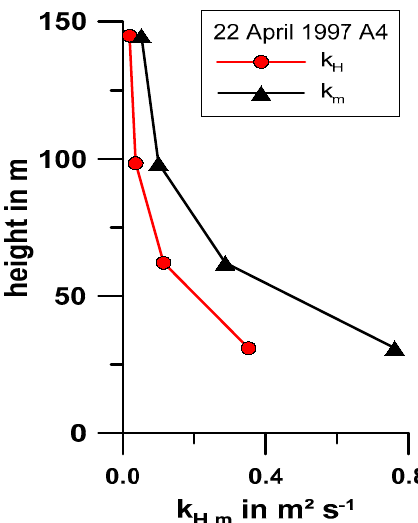
Figure A1. Profiles of the turbulent diffusion coefficients for heat (k H ) and momentum (k m ) from aircraft data around the A4 position for flight P1 on 22 April 1997.